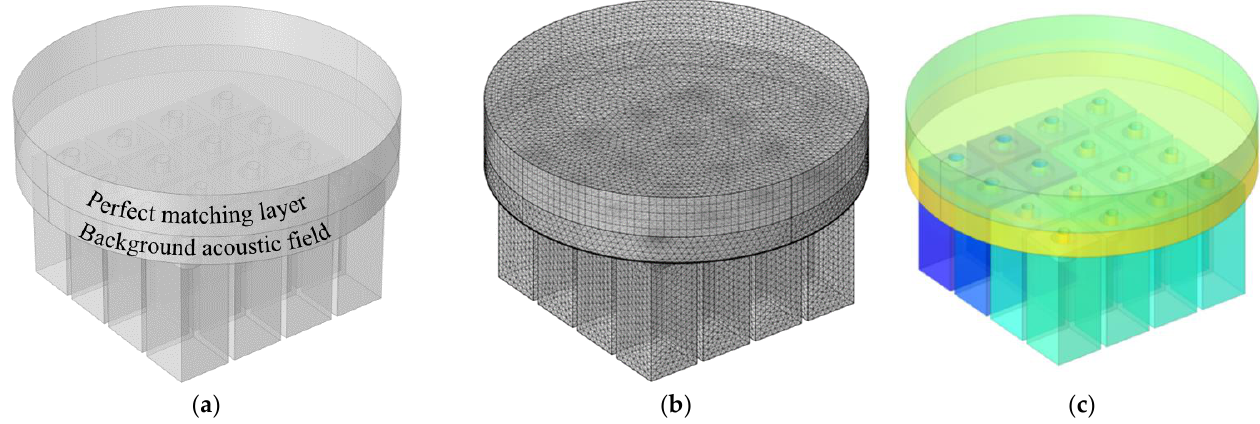
Figure 2. Three–dimensional finite element model for multi–groups parallel square Helmholtz resonators: ( a ) geometric model; ( b ) finite element mesh model; ( c ) sound pressure distribution.